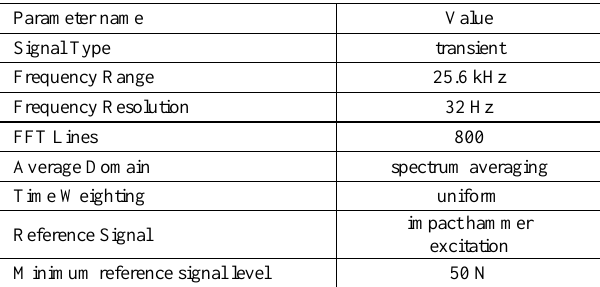
Table 1. Selected parameters of the FFT